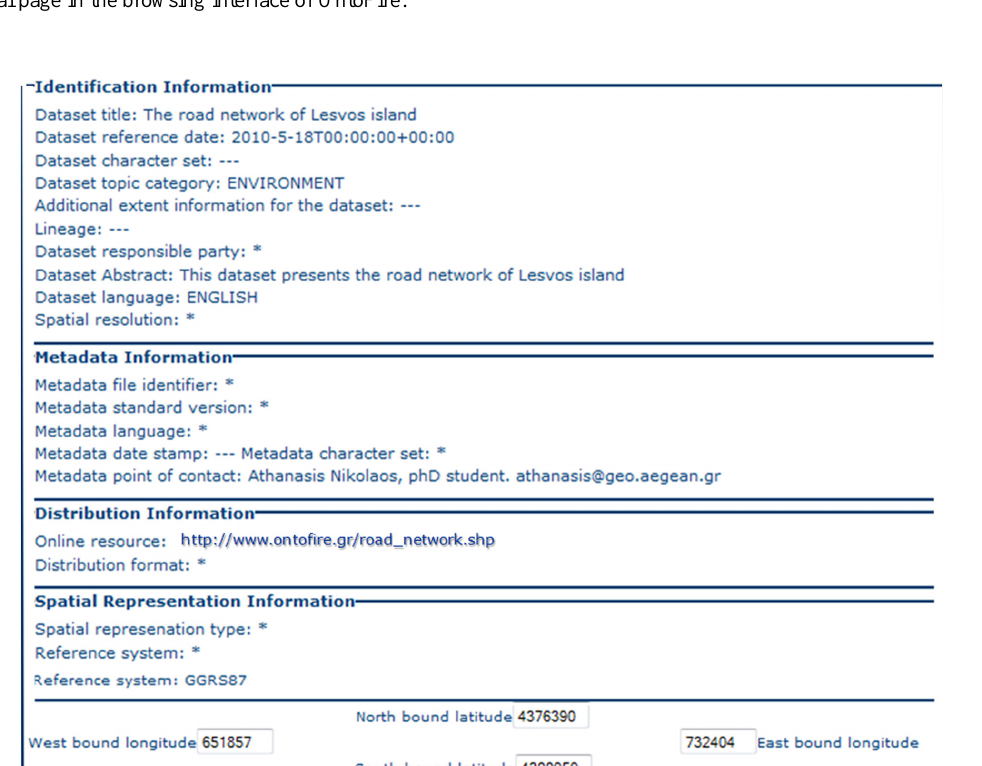
Fig. 5. The initial page in the browsing interface of OntoFire.